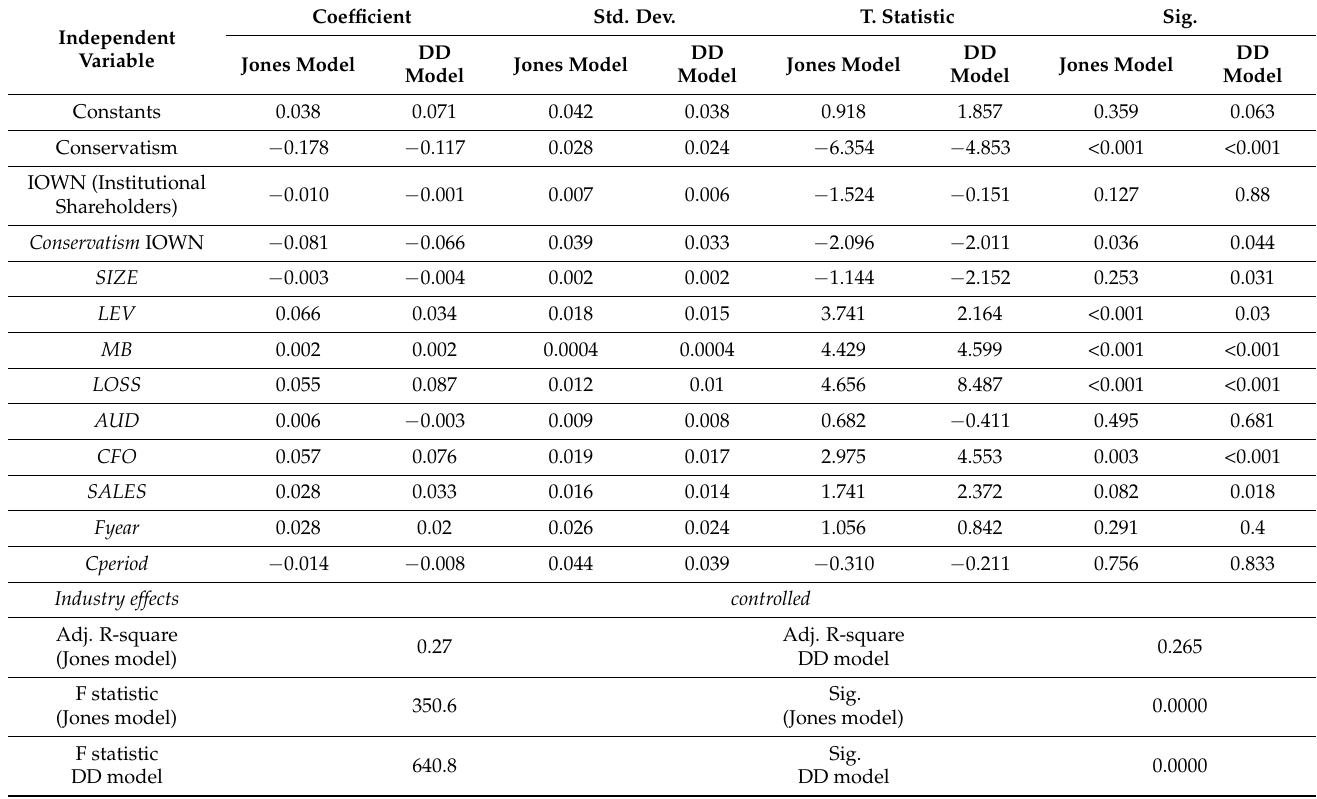
Table 6. The results of the fifth hypothesis